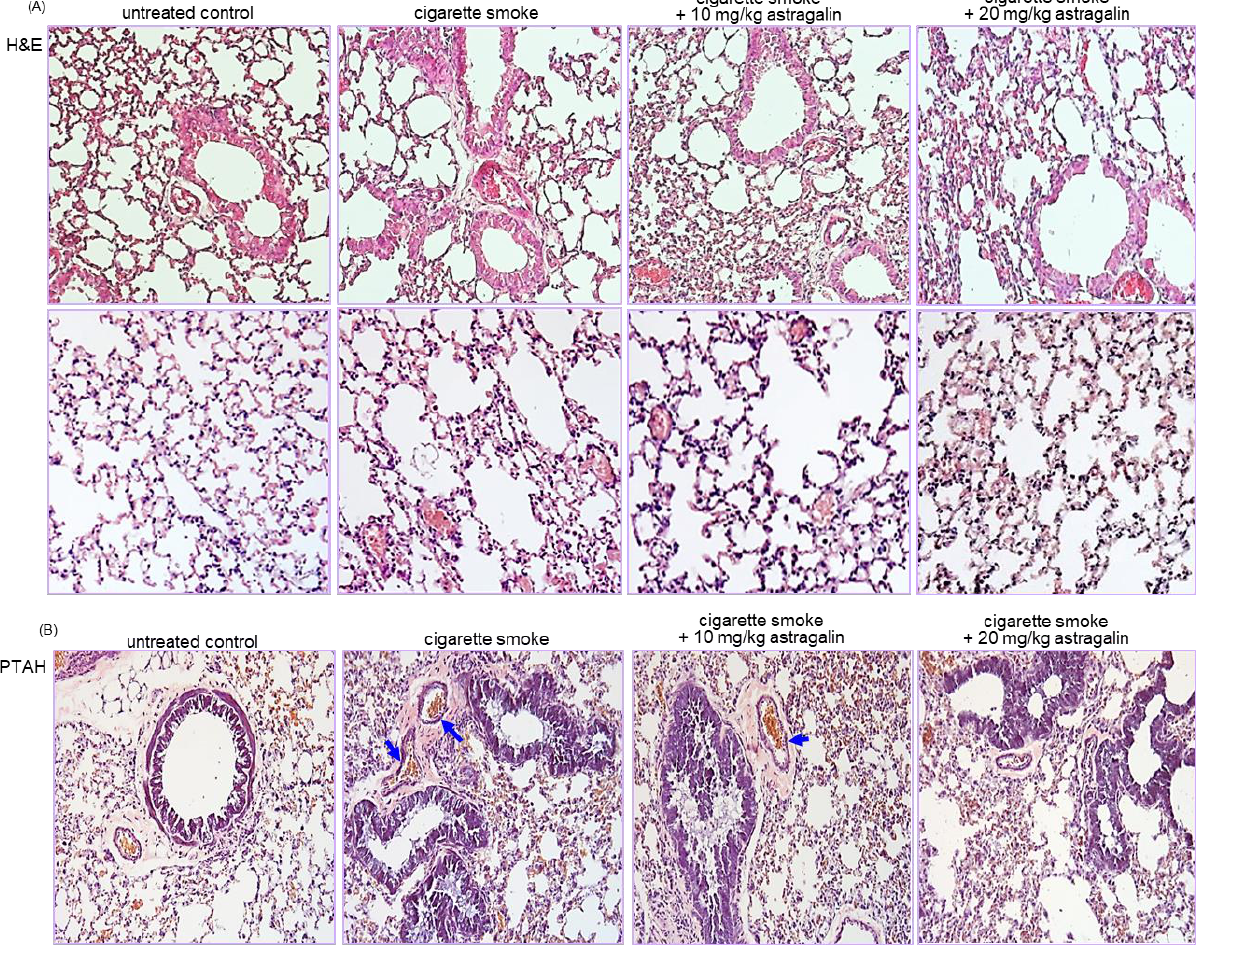
Figure 2. Suppressive effects of astragalin on airway injury ( A ) and thrombus formation ( B ) in airways and alveoli of cigarette smoke-exposed mice. Mice were orally administrated with 10 or 20 mg/kg astragalin and exposed to cigarette smoke. Histological examination was performed with phospho-tungstic acid hematoxylin (PTAH) and hematoxylin and eosin (H&E) staining. Tissue sections of small airways and alveoli were stained by using H&E reagent ( A ). PTAH staining showing blockade of thrombus by oral administration of astragalin in lung blood vessels of cigarette smoke-exposed mice ( B ). The blue arrows indicate thrombus formation. Each photograph is representative of four mice. Magnification: 200-fold.